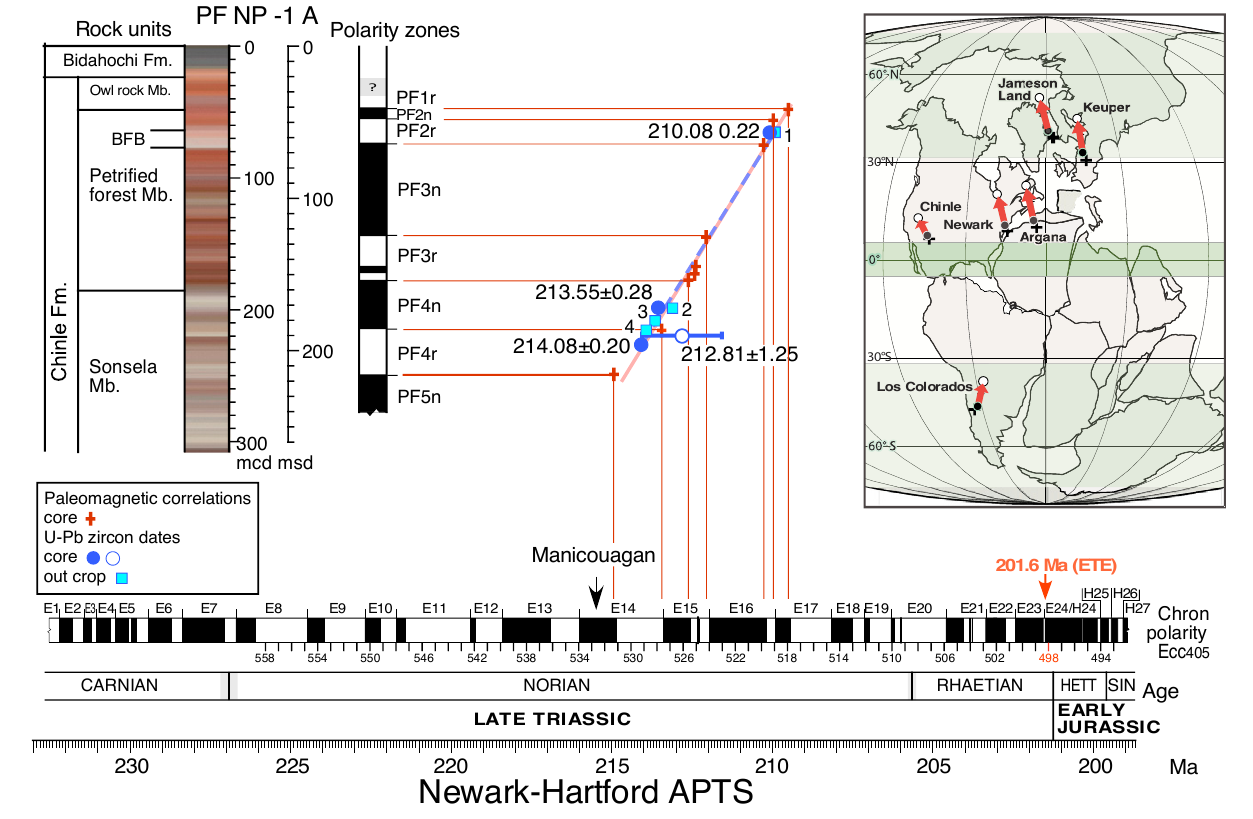
Figure 13. Depth versus age plot for core CPCP PFNP13-1A based on correlation of magnetostratigraphy with the Newark–Hartford APTS (from Kent et al., 2018). Stratigraphic units, graduated depths, and color log of CPCP PFNP13-1A. Red crosses are magnetozone boundaries in CPCP PFNP13-1A; correlated with the NH-APTS solid red line is a linear regression for base magnetozone PF1r to base magnetozone PF4r to their correlative chronological ages. Blue circles are U-Pb CA-ID-TIMS detrital zircon dates from CPCP PFNP13-1A; light blue squares are published U-Pb CA-TIMS detrital zircon dates from outcrop (from Ramezani et al., 2011; Atchley et al., 2013): 1, 209 . 93 ± 0 . 07Ma; 2, 213 . 12 ± 0 . 07Ma; 3, 213 . 63 ± 0 . 13Ma; 4, 213 . 87 ± 0 . 08 Ma. Linear regression on U-Pb ID-CA-TIMS dates (blue dashed line) based on sample data from core CPCP PFNP13-1A (excluding sample 177Q1); and light red line is regression of polarity boundaries in CPCP PFNP13-1A and Newark-Hartford APTS. U-Pb zircon date for Manicouagan crater impact melt rocks (Ramizani et al., 2005), which are characterized by normal polarity (Larochelle and Currie, 1967), is shown for reference. Inset shows a paleocontinental reconstruction of Pangea (from Kent et al., 2018) positioned according to a 220Ma mean composite paleopole (Kent et al., 2014) with some key continental localities indicated by filled circles connected by arrows to their relative positions at 200Ma by open